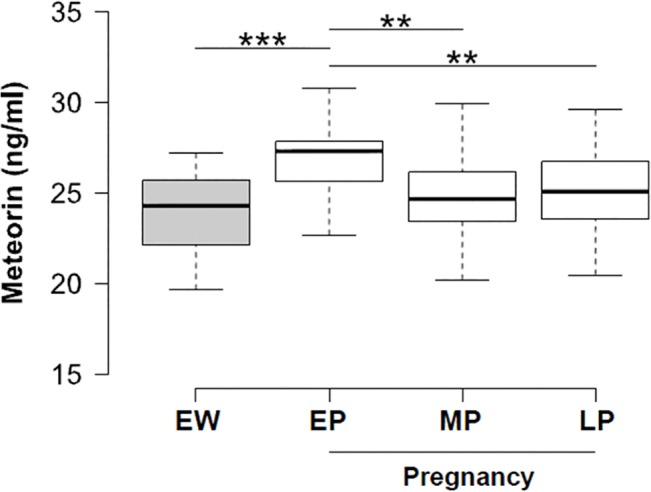
Serum METRN levels in the three trimesters of pregnancy and in a group of eumenorrheic woman.The highest levels of METRN are observed in early pregnancy (EP) and then decline with advancing gestation in the subsequent periods, in middle pregnancy (MP), and late pregnancy (LP), with this reduction in serum METRN being statistically significant (p <0.01). Moreover, significant differences were observed when comparing serum METRN in the groups of eumenorrheic women (EW) and EP (p <0.001).